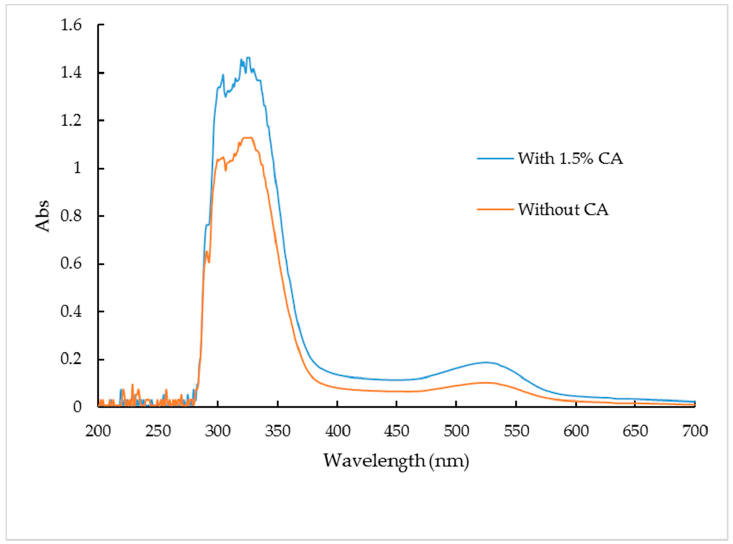
Figure 1. Ultraviolet-visible (UV) spectra of purple sweet potato anthocyanins.